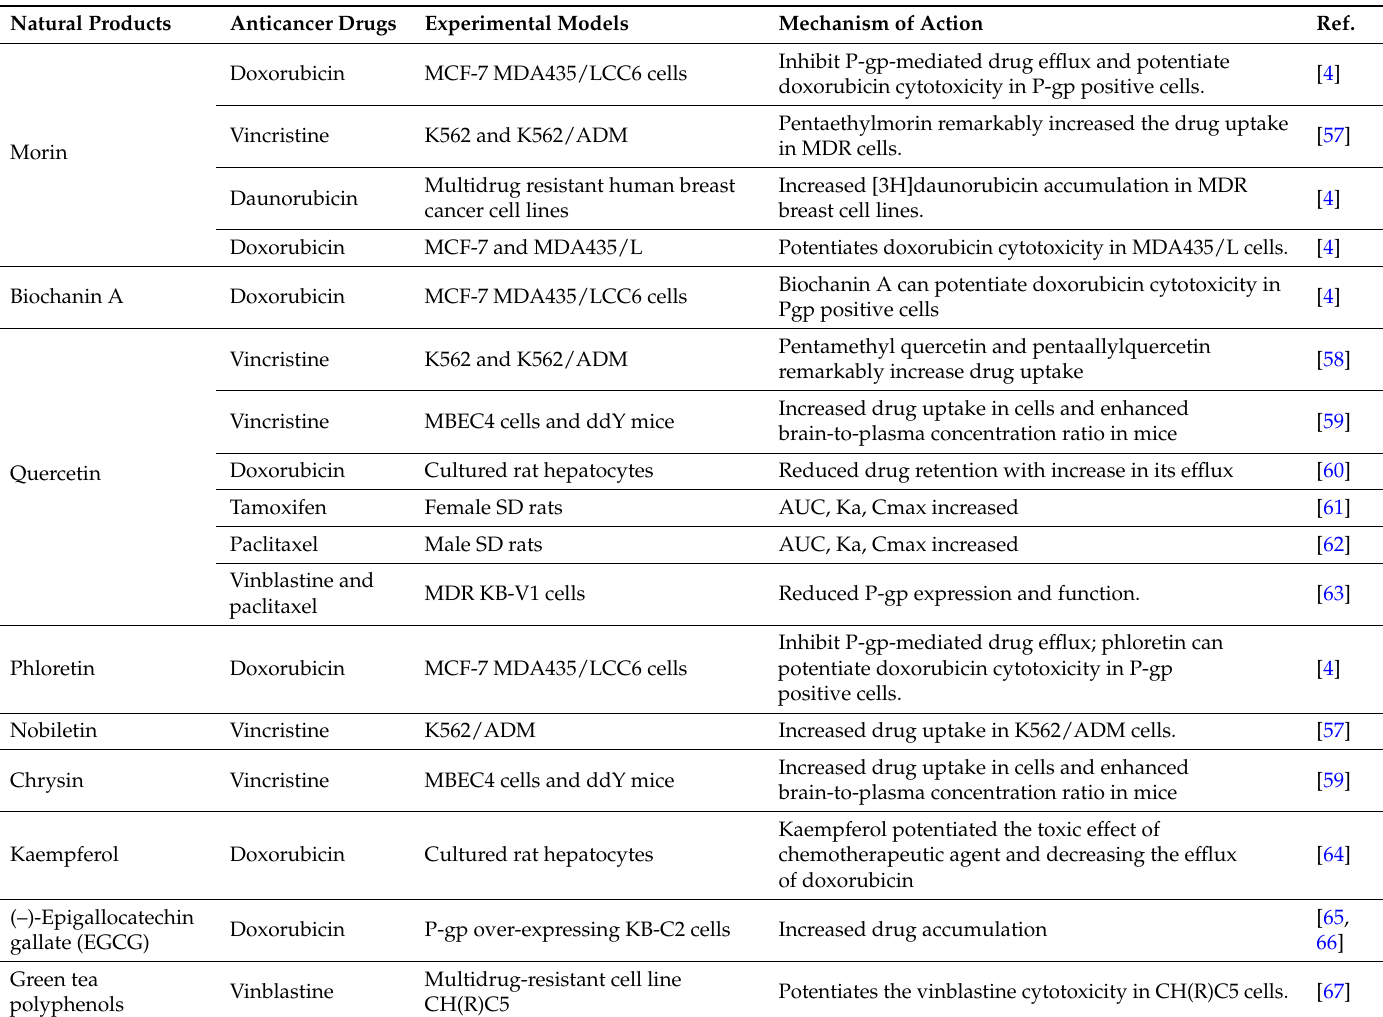
Table 3. Chemosensitizing potential of selected South Asian medicinal